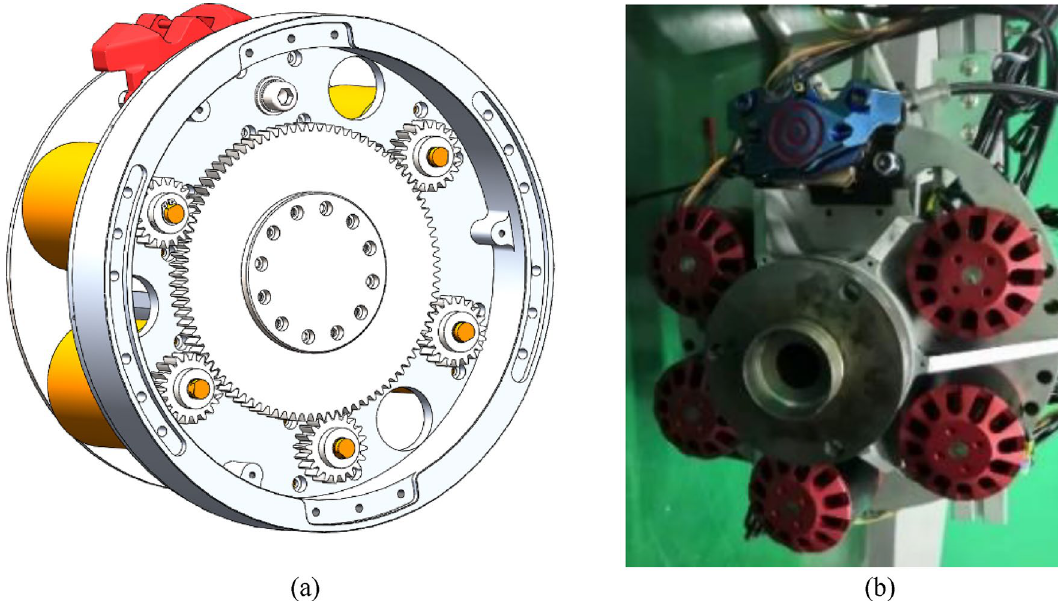
Figure 3. ( a ) Schematic of wheel and motor (outside view), ( b ) actual physical figure of wheel and motor (inside